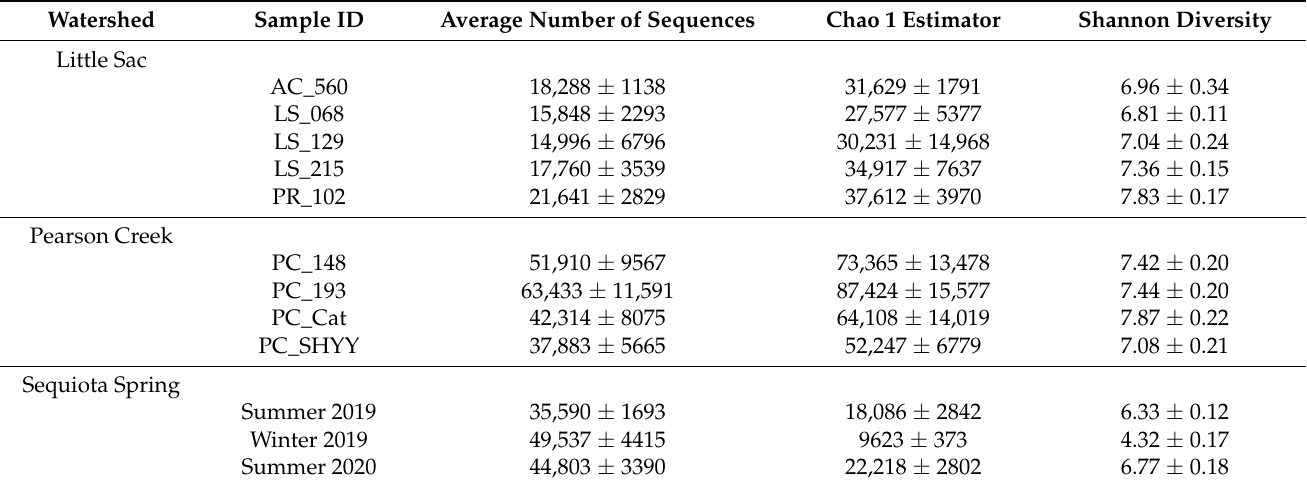
Table 1. The overall bacterial species richness and diversity across different sites within different sampling